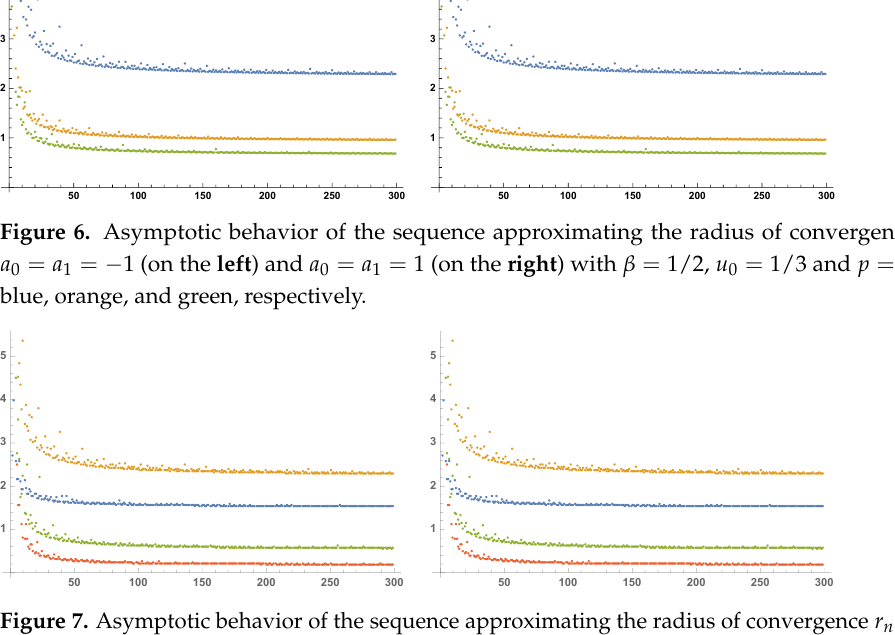
Figure 7. Asymptotic behavior of the sequence approximating the radius of convergence r n for a 0 = a 1 = − 1 (on the left ) and a 0 = a 1 = 1 (on the right ) with u 0 = 1/3, p = 1, and β = 1,1/2,1/3,1/4 in blue, orange, green, and red,